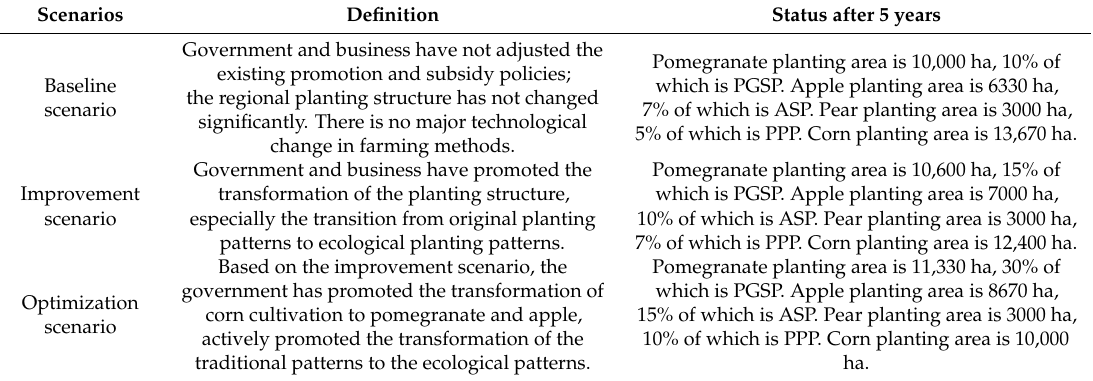
Table 3. Setting and comparing of different